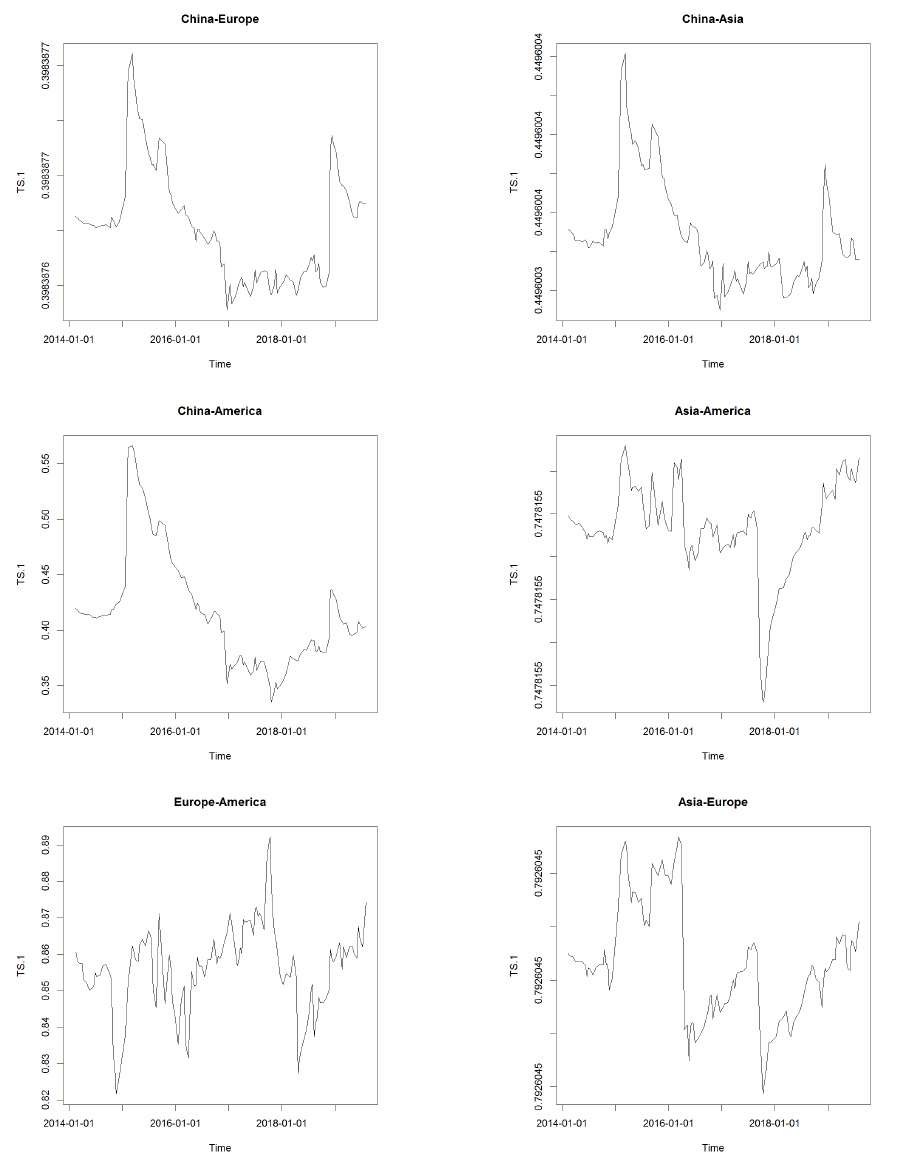
Fig. 1 Dynamic correlation coefficient of gasoline price